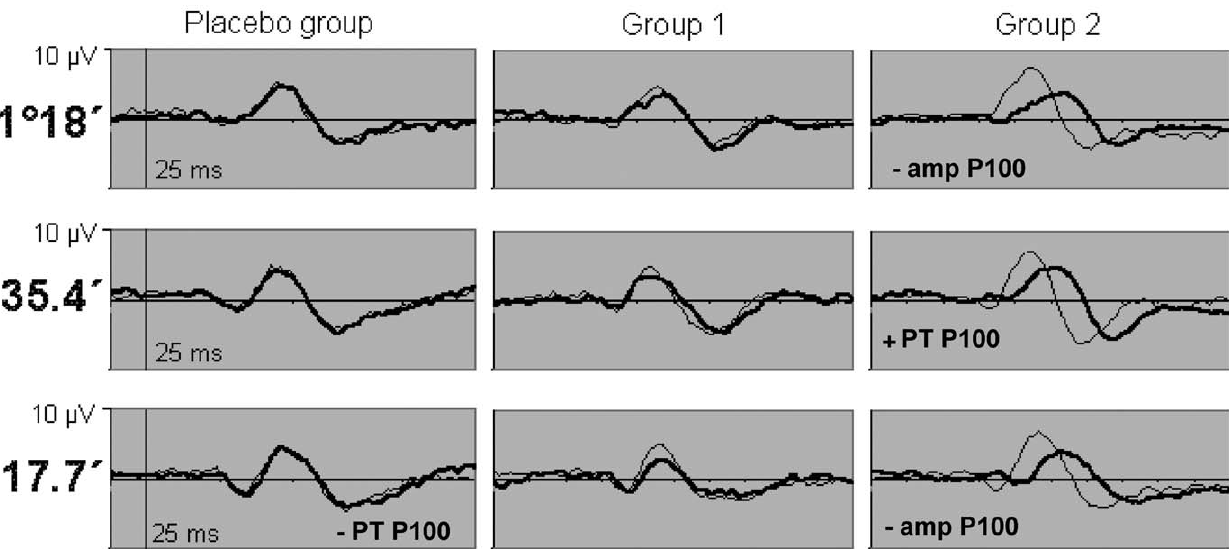
Figure 7. Mean pattern visual evoked potential. Recordings for each group and check size. Stimulation of the left eye with natural pupil. Thin lines: baseline recordings, thick lines: recordings 4 hours after treatment. This figure shows a virtually dose-dependent amplitude decrease and peak time prolongation. Significant increments ( + ) and decrements ( 2 ) of the deflections as compared to baseline are marked in the according graphs (PT=peak time, amp=amplitude).